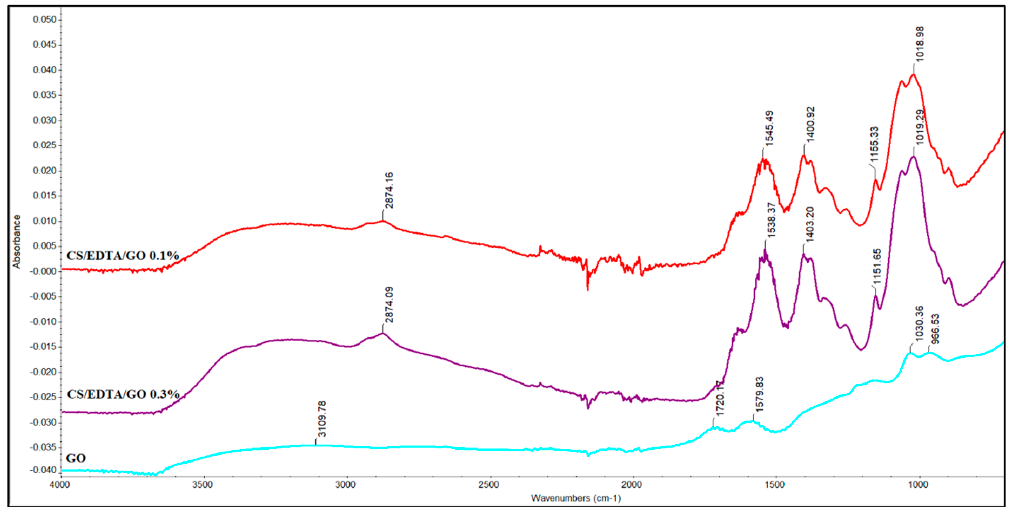
Figure 3. FTIR spectra for GO, CS/EDTA/GO 0.1% and CS/EDTA/GO 0.3%.